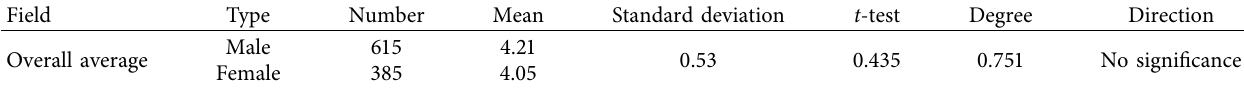
Table 8: Arithmetic means, standard deviations, and t -test according to the type of